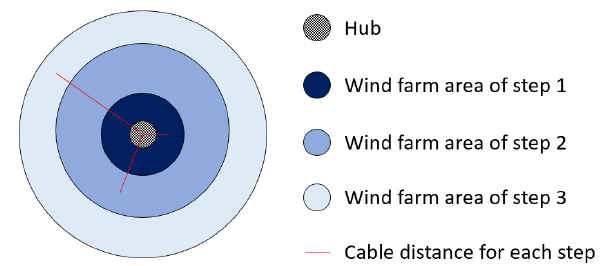
Figure 6. Illustration of hub-connected wind farm modeling, the area of the different wind farm steps, and the array cable distance used in the assumption calculation of each step.